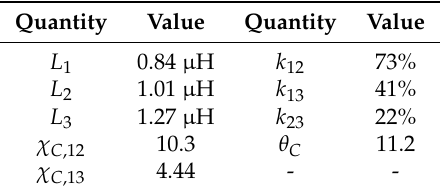
Table 3. Calculated values for the considered capacitive wireless power transfer (CWPT)